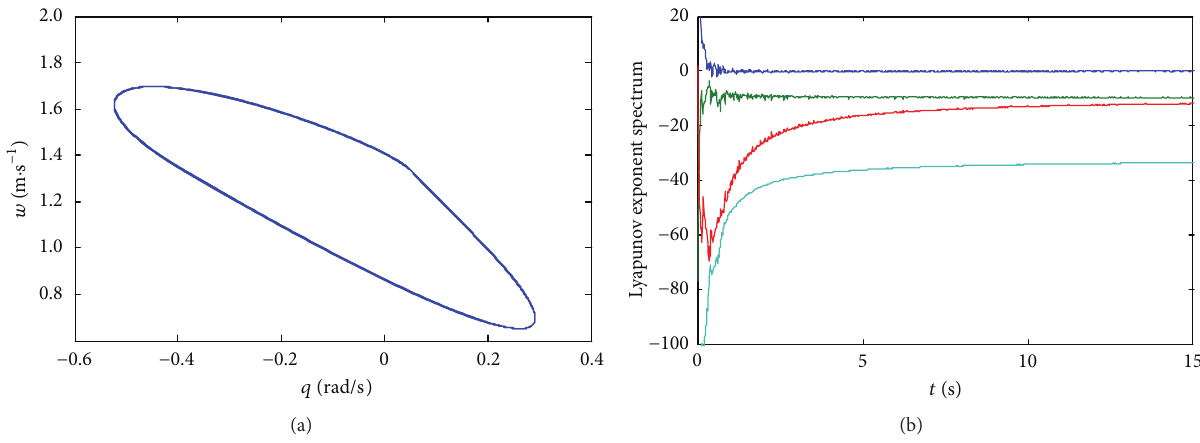
Figure 9: (a) Phase trajectory diagram in 𝑤 − 𝜃 plane when 𝑘 = 5 and (b) Lyapunov exponent